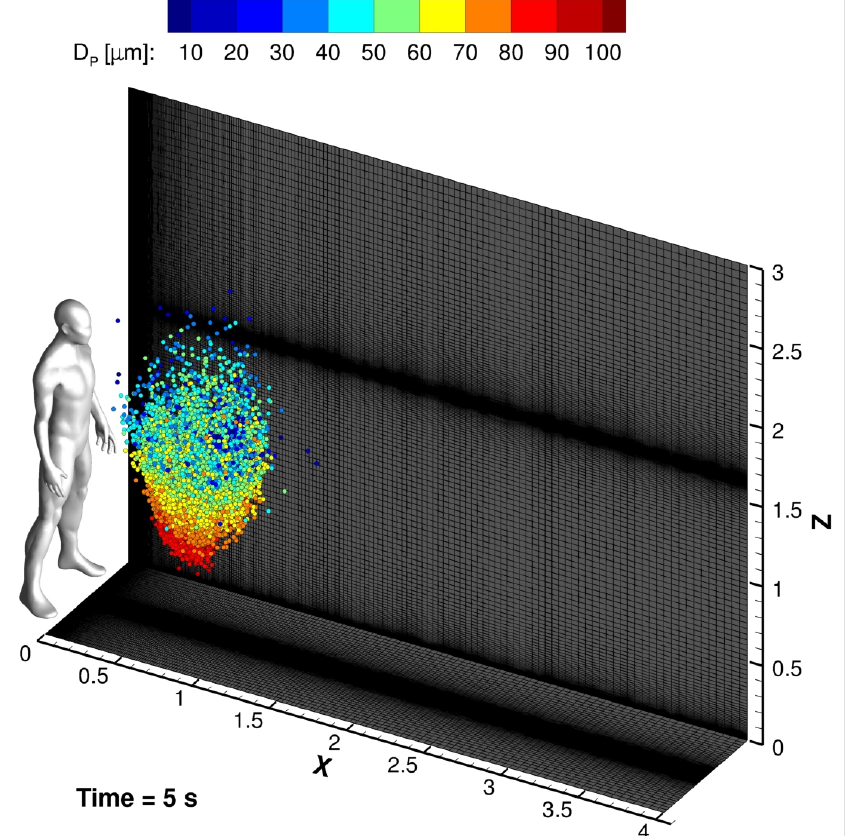
Figure 1. Computational domain